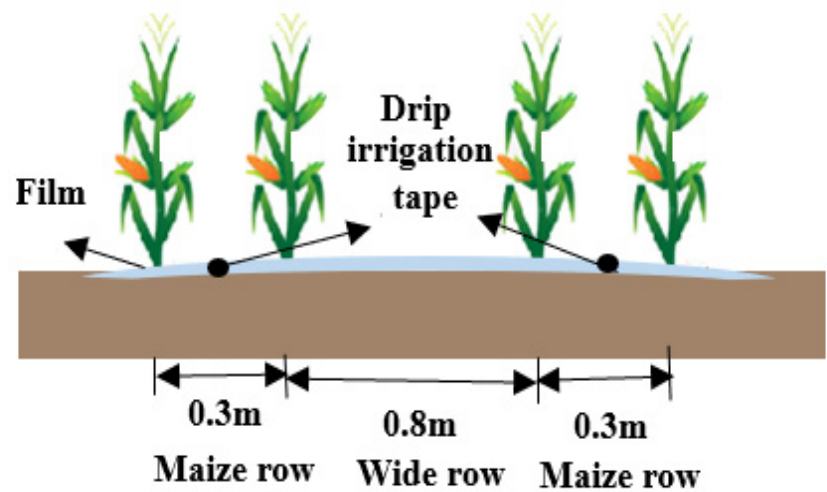
Figure 2. Schematic diagram of cultivation mode for maize.